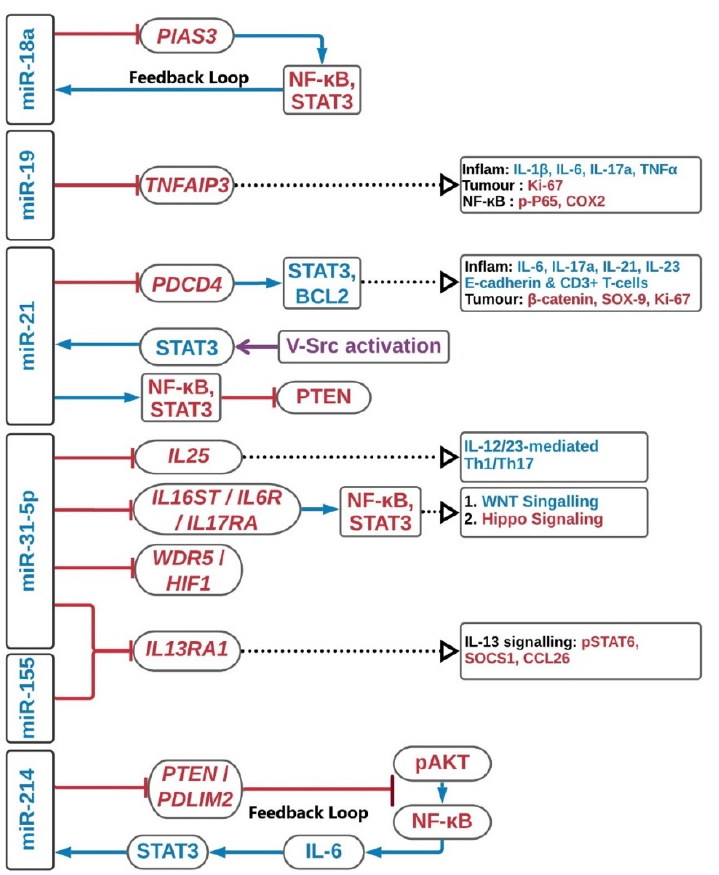
Figure 1. Upregulation of miRNAs in colitis-associated colorectal cancer. The schematic diagram summarizes the major pathways in the upregulation of miRNAs. Red, blue and purple in the diagram represent inhibition, regulation and enhancer, respectively. Inflam,